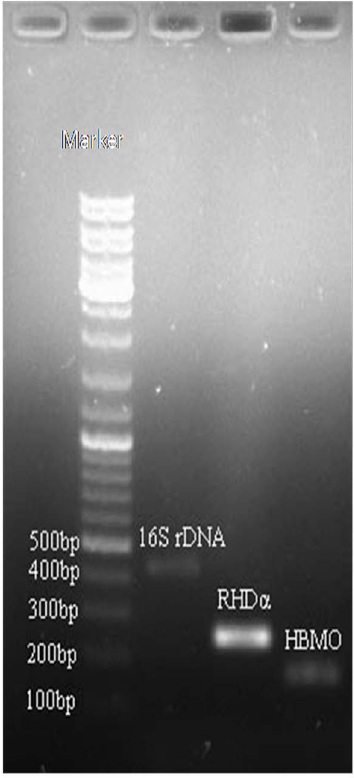
Figure 3. Real-Time PCR product of the 16S rRNA gene, PAH ring-hydroxylating dioxygenase, and 4-hydroxybenzoate 3- monooxygenase gene in Novosphingobium pentaromativorans